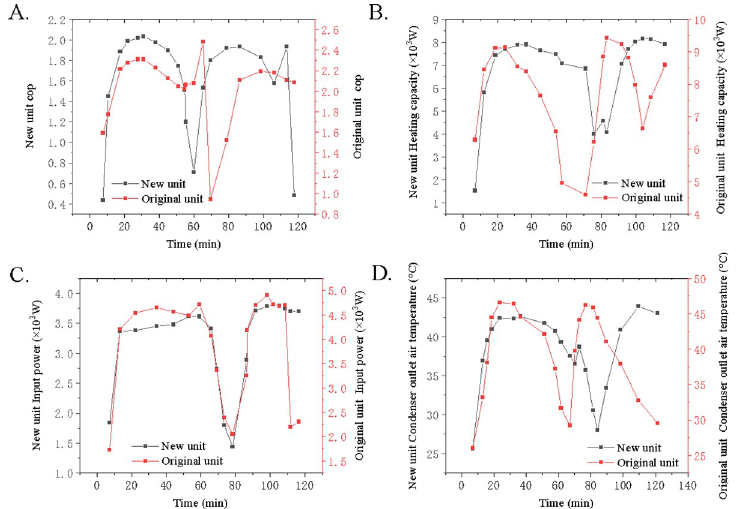
Fig 10. Heat transfer characteristics under working condition 1 at different times. Fig A: Coefficient of Performance (COP), Fig B: heating capacity, Fig C: input power, Fig D: condenser outlet air temperature.